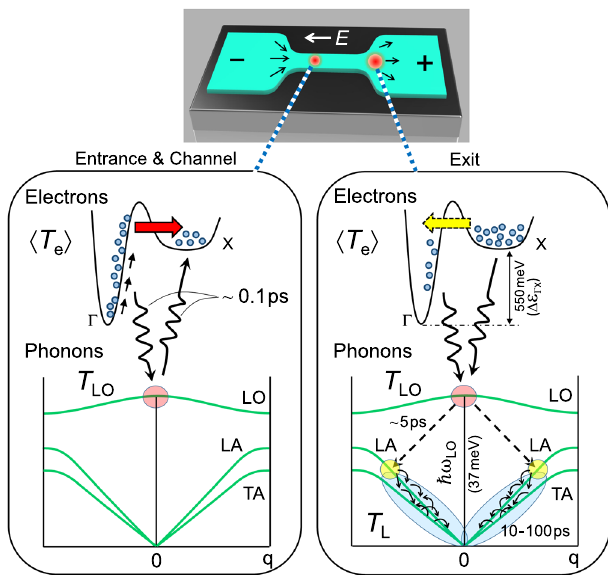
Fig. 5 Schematic representation of the kinetics of hot electrons and hot phonons. As electrons enter a narrow constriction channel, they are rapidly accelerated by intense electric fi eld E and the effective electron temperature < T e > is elevated, as studied with SNoiM. It causes frequent LO-phonon emission in the Γ -valley (down-pointing wavy arrow in the left column) as well as Γ → X intervalley electron transfer (fat red arrow in the left column). The effective LO-phonon temperature, T LO , is signi fi cantly elevated, but X-valley electrons are not ef fi ciently heated by E , so that the LO phonons emitted by Γ -valley electrons are strongly absorbed by X- valley electrons (wavy arrow pointing upward in the left column), suppressing the net energy loss in the channel and causing the “ hot-phonon bottleneck effect ” . As the electrons exit the channel, Γ -valley electrons are no longer rapidly accelerated by E , but energy is still fed via intervalley back-transfer from X valleys (fat yellow arrow in the right column). T LO drops faster than T X so that X-valley electrons change to emit LO phonons (wavy arrow pointing downward in the right column). The electrons dissipate net energy, causing prominent non-local energy dissipation near the exit. Emitted LO phonons quickly decay into two LA phonons (via Klemens channel), eventually thermalize slowly into heat, and are primarily composed of long wavelength acoustic phonons that are sensed with SThM as the lattice temperature T L